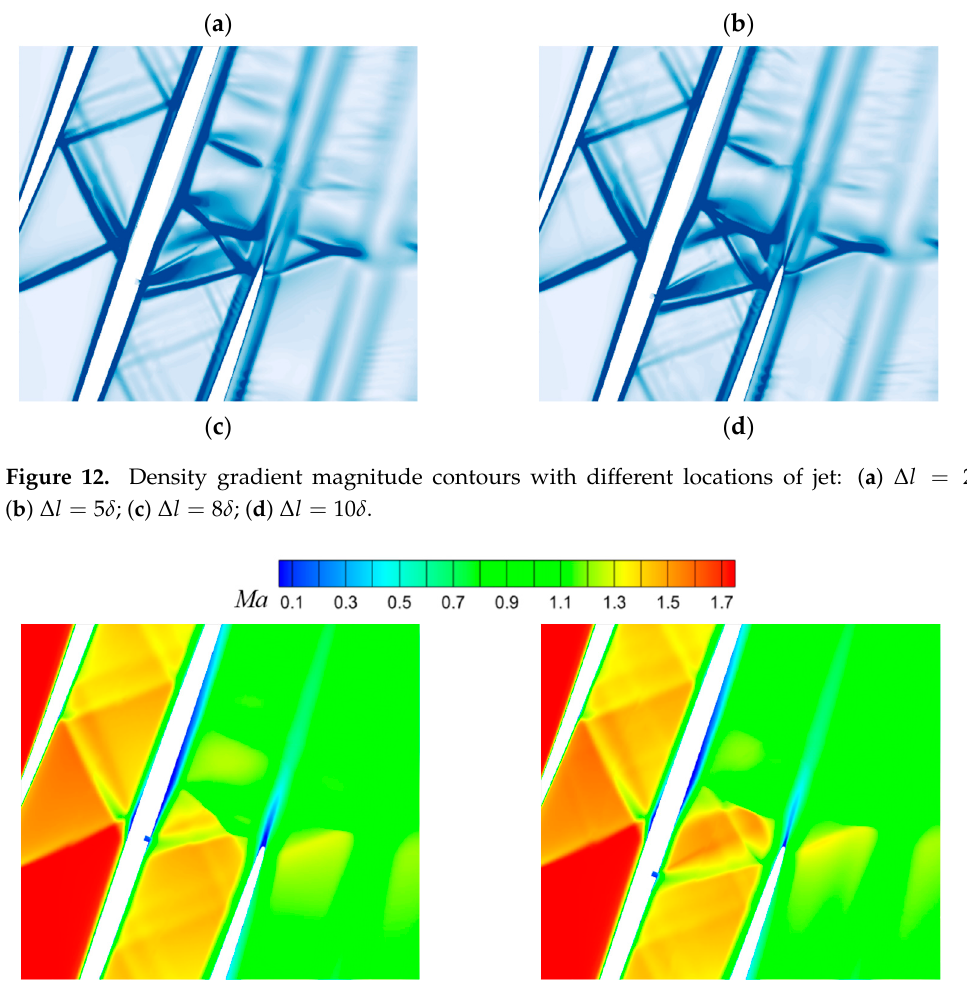
Figure 13. Mach number contours with different locations of jet: ( a ) Δ𝑙 = 5𝛿 ; ( b ) Δ𝑙 = 10𝛿 . Meanwhile, the change in back pressure affected the location of the trailing-edge shock on the blade wall. Then, multiple jet slots could be laid along the chordal direction, enabling the jet slot in the optimal control location to work selectively according to the actual operating conditions.